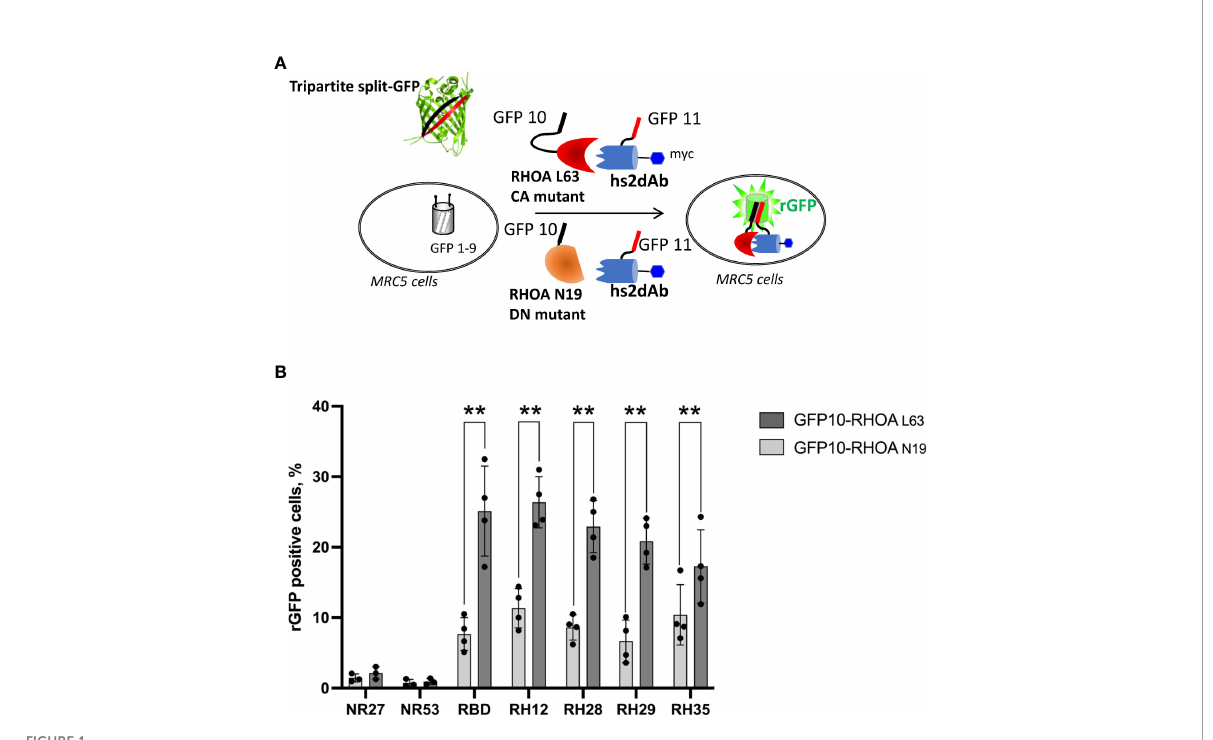
FIGURE 1 The tripartite split GFP assay demonstrates the intracellular interaction and the selective recognition of the active RHO conformation by the selected intrabodies. (A) Principle of the tripartite split-GFP complementation assay adapted to assess hs2dAb/RHO interaction. b -strand 10 (GFP10) and b -strand 11 (GFP11) are fused to RHOA mutants (either DN RHOA N19 or CA RHOA L63) and hs2dAb, respectively. These constructions are transfected in a MRC5 cell line that constitutively expresses the detector fragment GFP1 – 9 ( b -strands 1 – 9). When protein interaction occurs, GFP10 and GFP11 strands are tethered and then spontaneously associate with GFP1 – 9 fragment to form a full-length GFP. If the two proteins do not interact, GFP10 and GFP11 are not tethered and entropy is too high to allow complementation with GFP1 – 9. (B) Percentage of reconstituted GFP (rGFP) fl uorescent cells analyzed by fl ow cytometry for the indicated transfection conditions. P-values were calculated using a Student ’ s t test. **,